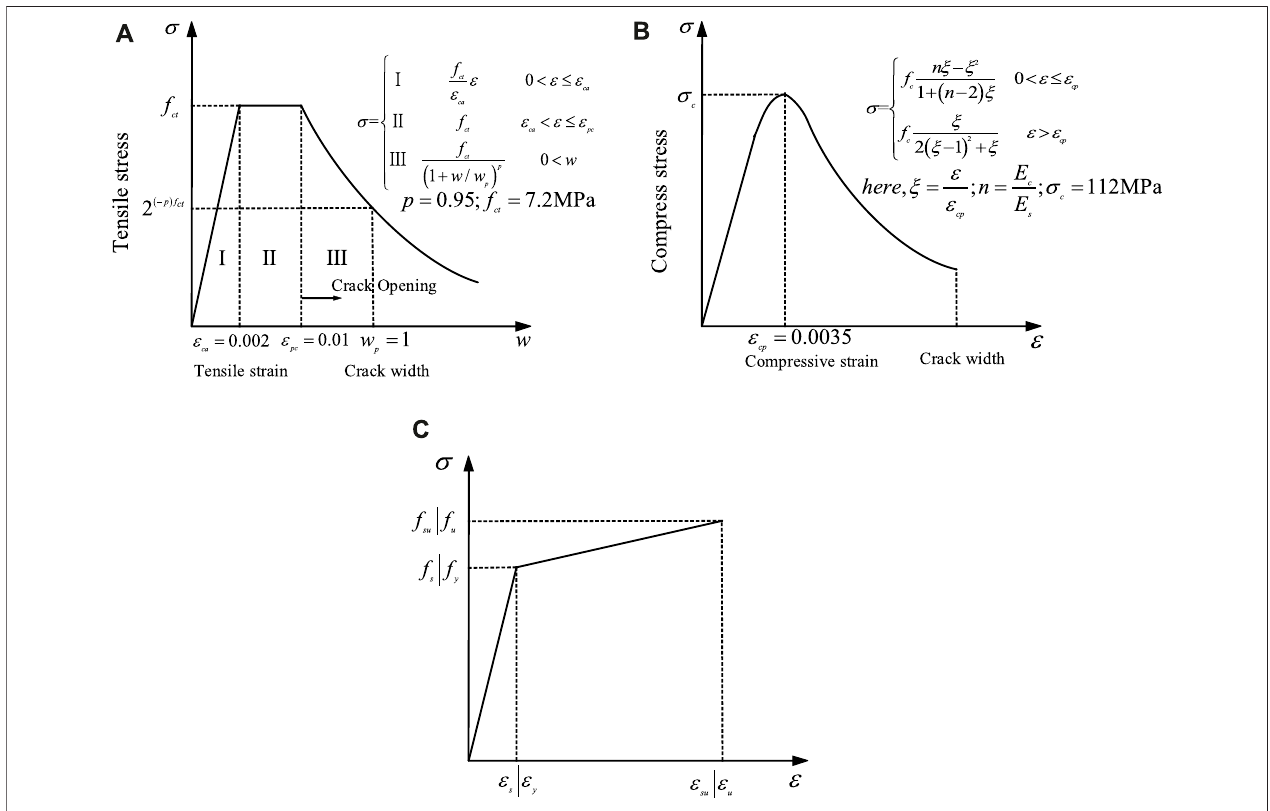
FIGURE 7 | Constitutive model of UHPC in (A) tension (Zhang et al., 2015), (B) compression (Yang, 2007), and (C) steel (Ministry of Housing and Urban-Rural Development of the People ’ s Republic of China, 2015).